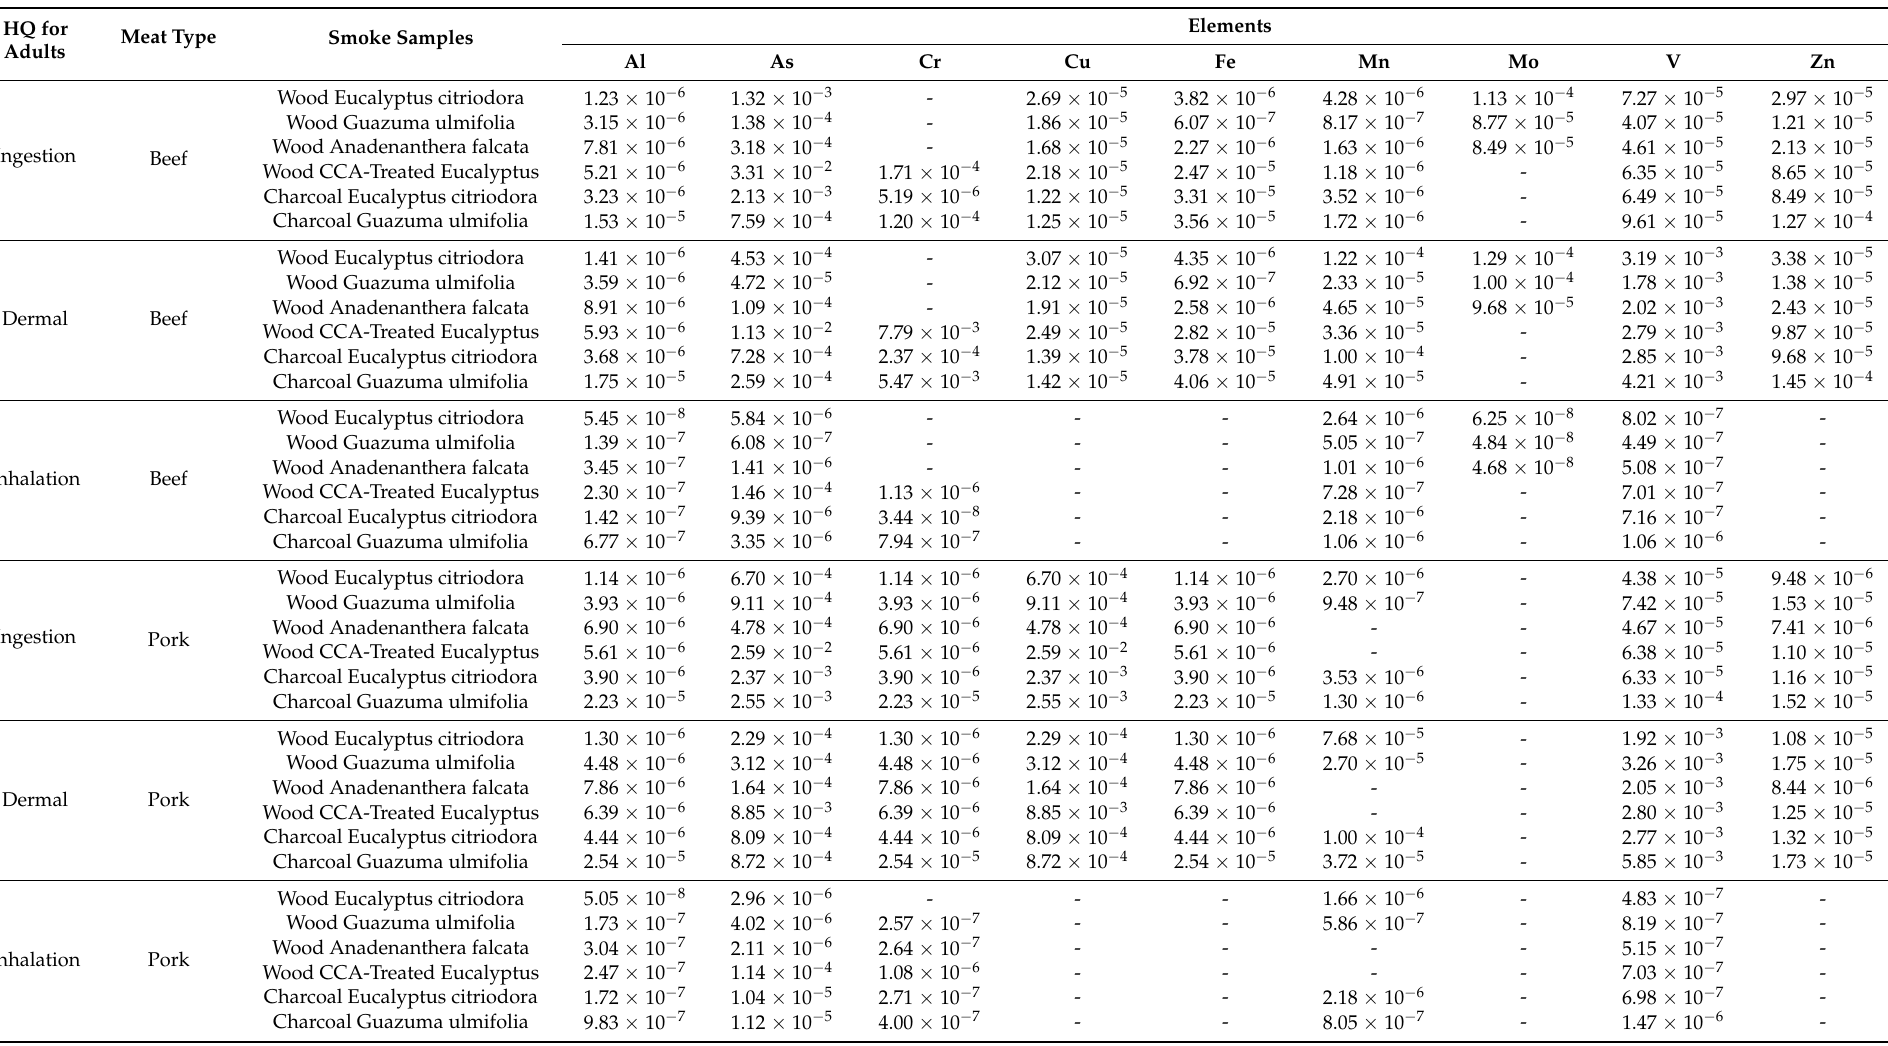
Table 4. Hazard quotient (HQ) values for Al, As, Cr, Cu, Fe, Mn, Mo, V, and Zn in adults exposed to smoke via ingestion, dermal contact, and